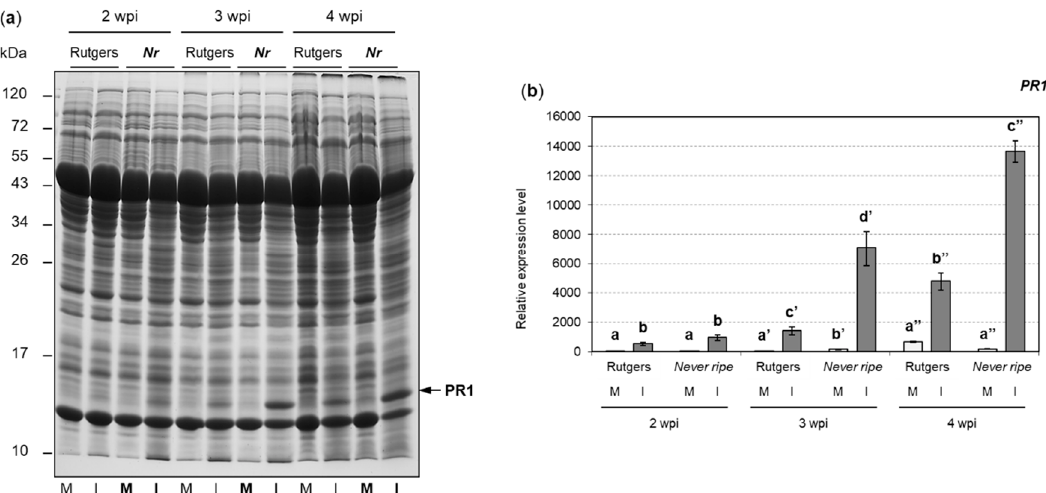
Figure 5. Pathogenesis related protein 1 (PR1) analysis at 2, 3, and 4 weeks post inoculation (wpi) in mock (M) and CEVd infected (I) Rutgers and Never ripe tomato leaves. ( a ) SDS-PAGE analysis of soluble proteins. Protein size markers (kDa) are indicated on the left. The arrow on the bottom right indicates the PR1 protein. ( b ) mRNA expression of PR1 determined by qRT-PCR Expression levels are relative to Rutgers mock plants and normalized to the tomato actin gene. Results correspond to the mean of at least 2 independent plants ± SD of at least three technical replicates, and one representative experiment is displayed. Data were analyzed using a Mann–Whitney test and di ff erent letters indicate significant di ff erences ( p < 0.05). Number of ( ’ ) indicates di ff erent weeks.